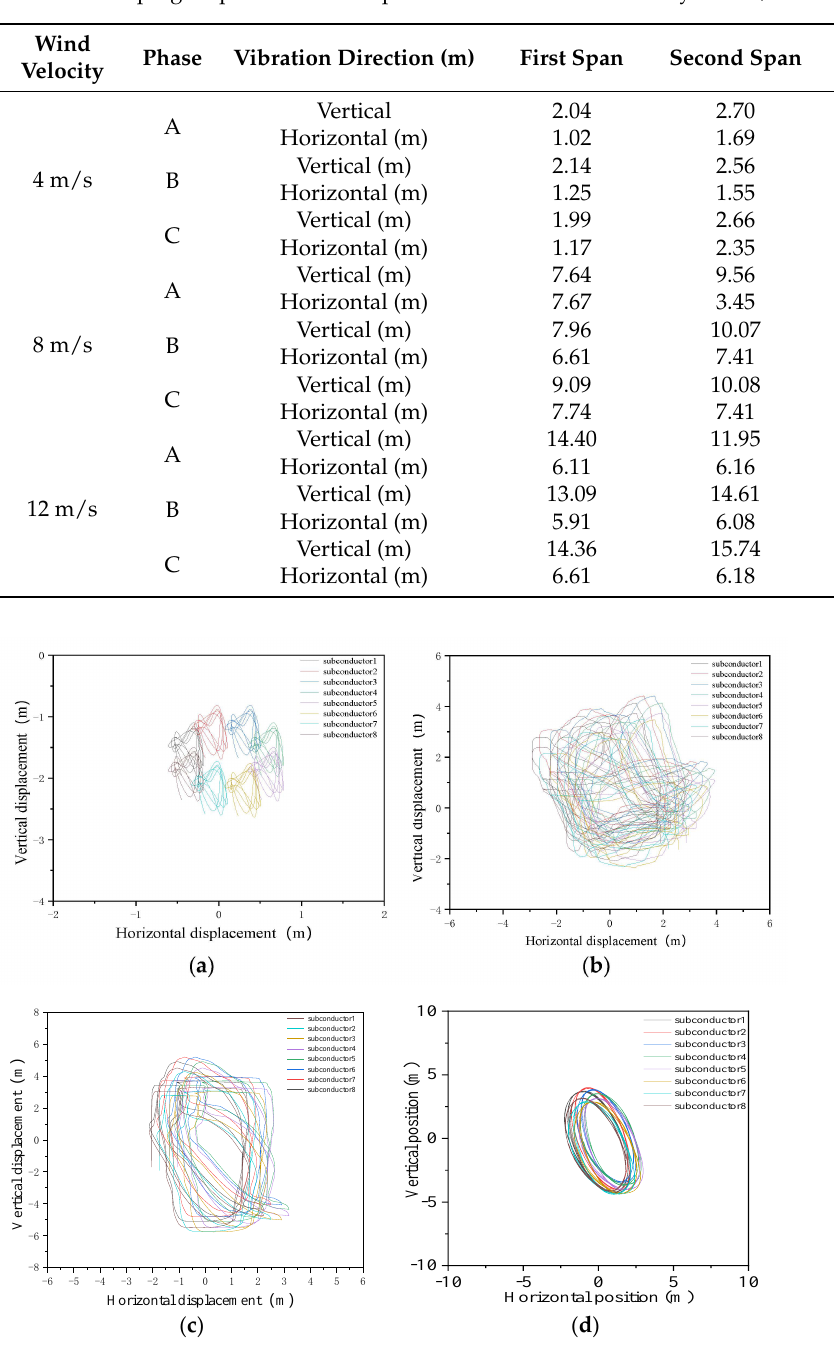
Table 3. Galloping amplitude of each span conductor at wind velocity of 8 m/s.